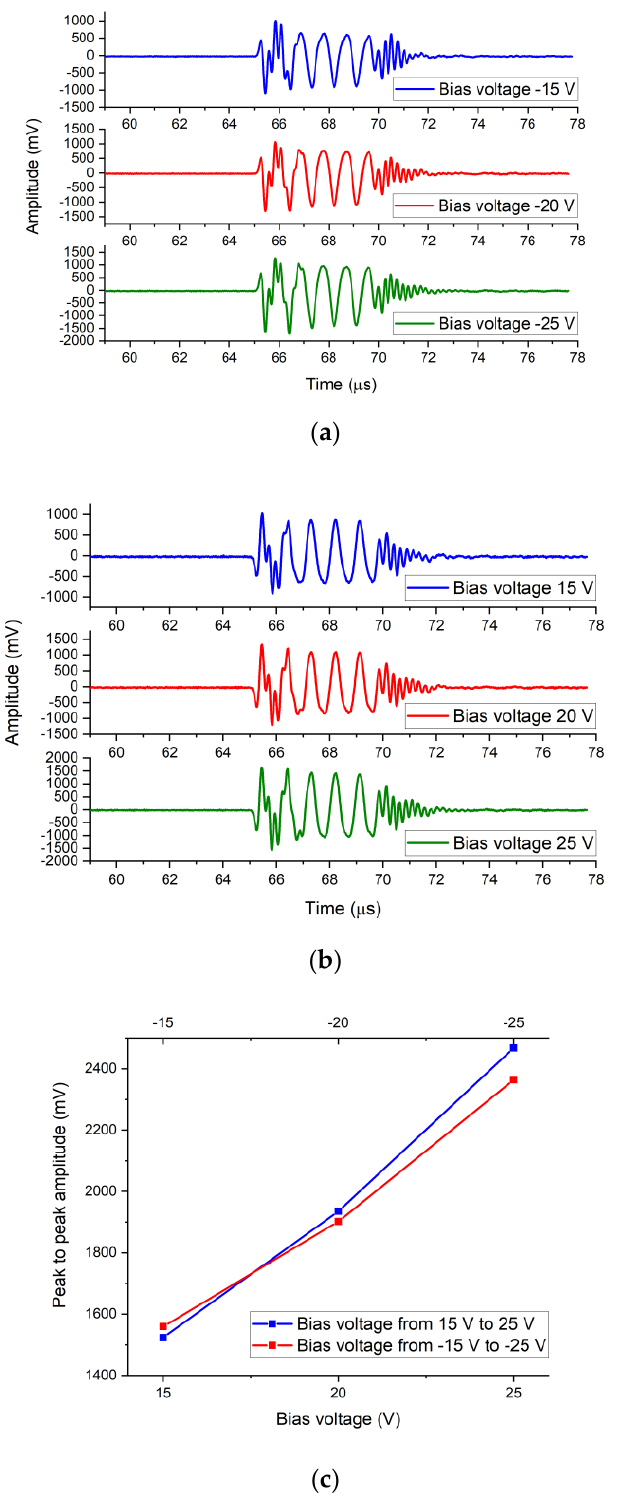
Figure 9. ( a ) Response waveforms of the CMUT-1# driven by the DC bias voltages from −15 V to −25 V; ( b ) response waveforms of the CMUT-1# driven by the DC bias voltages from 15 V to 25 V; ( c ) peak-to-peak response amplitude of the CMUT-1# driven by different DC bias